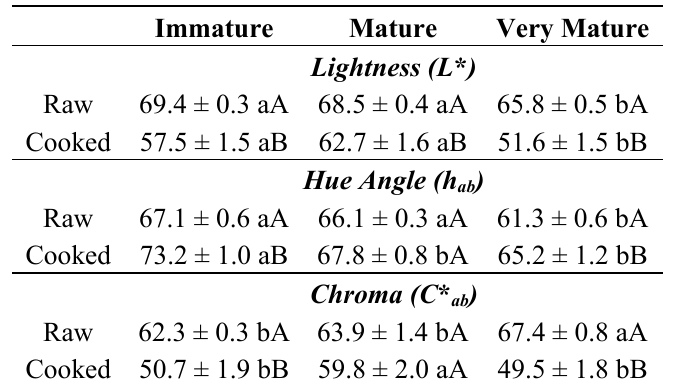
Table 2. Lightness ( L* ), Chroma ( C* ab ) and Hue angle ( h ab ) color of raw and cooked pulp from squash at three stages of